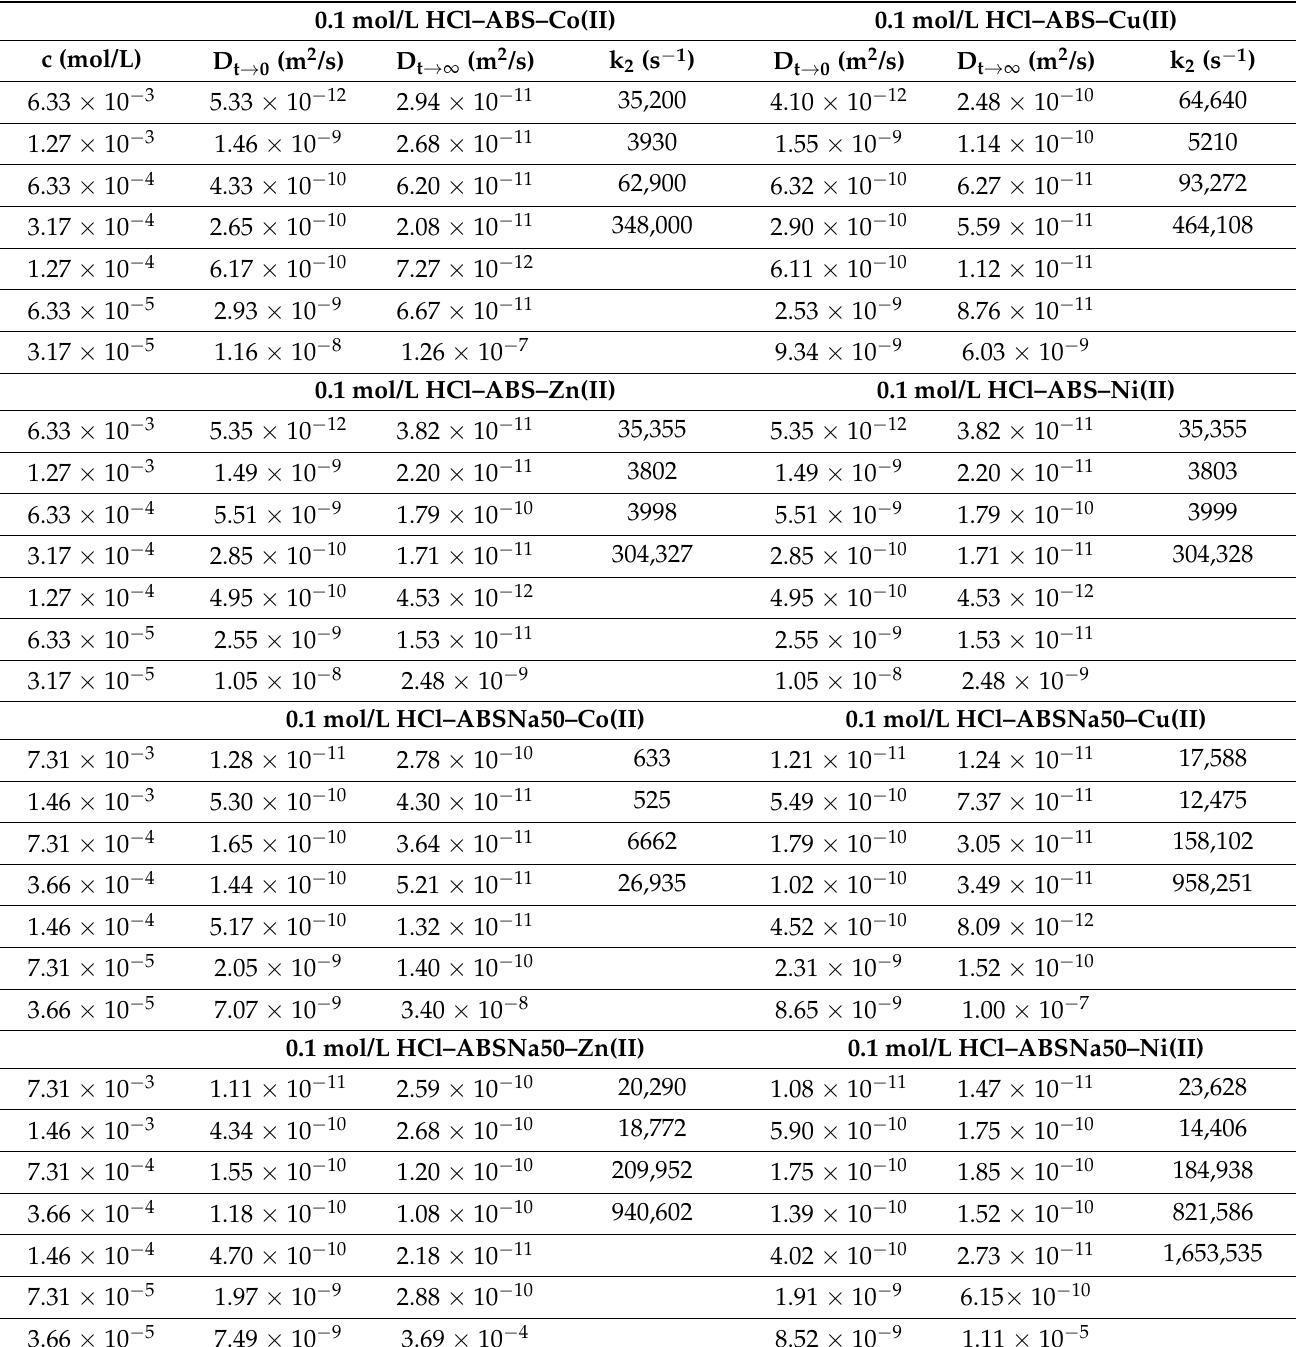
Table 3. Diffusion coefficients and micelle dissociation rate constant parameters obtained in the systems containing the AS surfactants (chosen